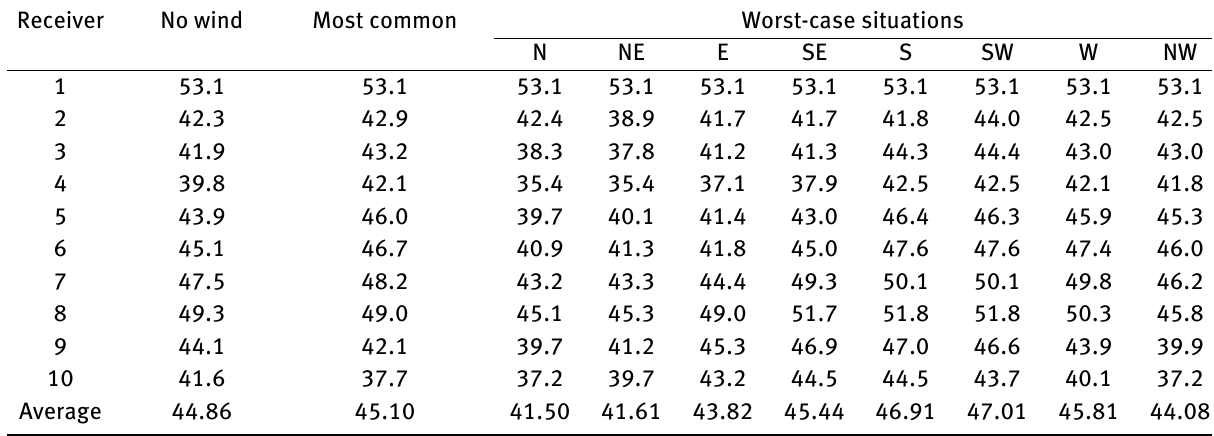
Table 3: Noise levels (Lnight) for different scenarios based on wind speed and direction